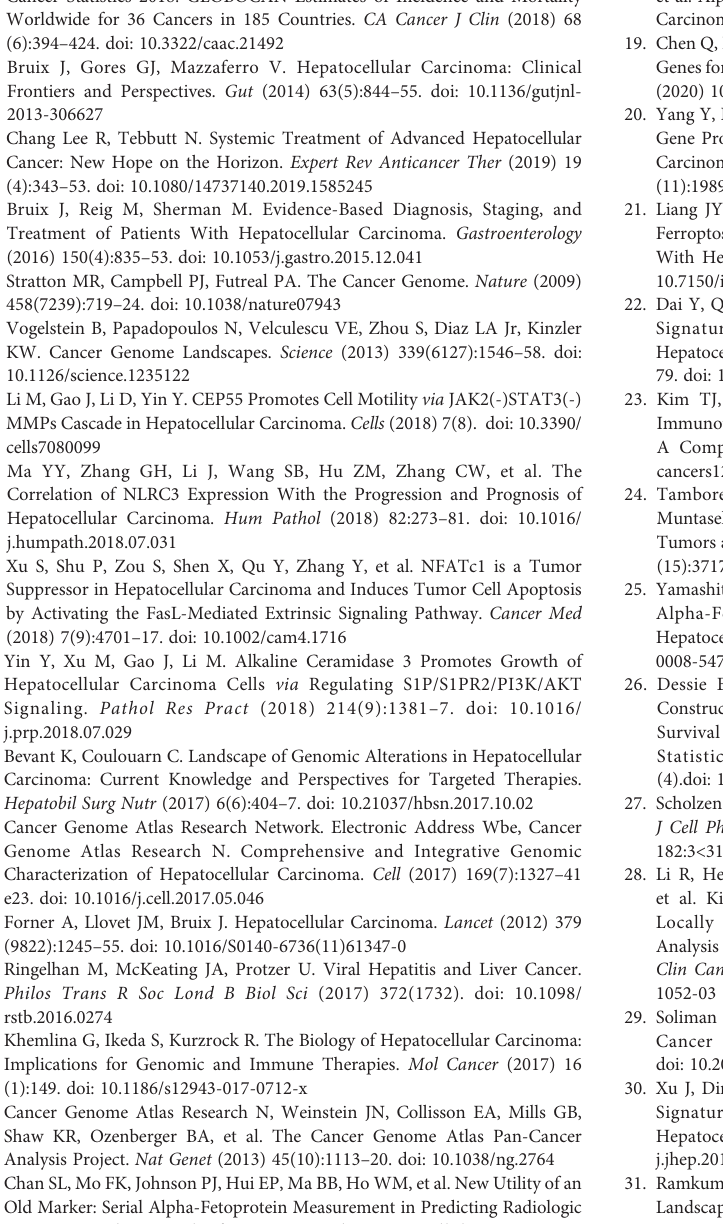
Supplementary Figure 4 | The prognostic gene expression between HCC and para-cancerous tissues in the TCGA cohort and Kaplan – Meier survival curve of each prognostic gene for the patients with HCC in TCGA dataset. Supplementary Figure 5 | The prognostic gene expression in different groups strati fi ed by clinical characteristics. Supplementary Figure 6 | The risk score and prognostic gene expression in different immune in fi ltration subtypes.